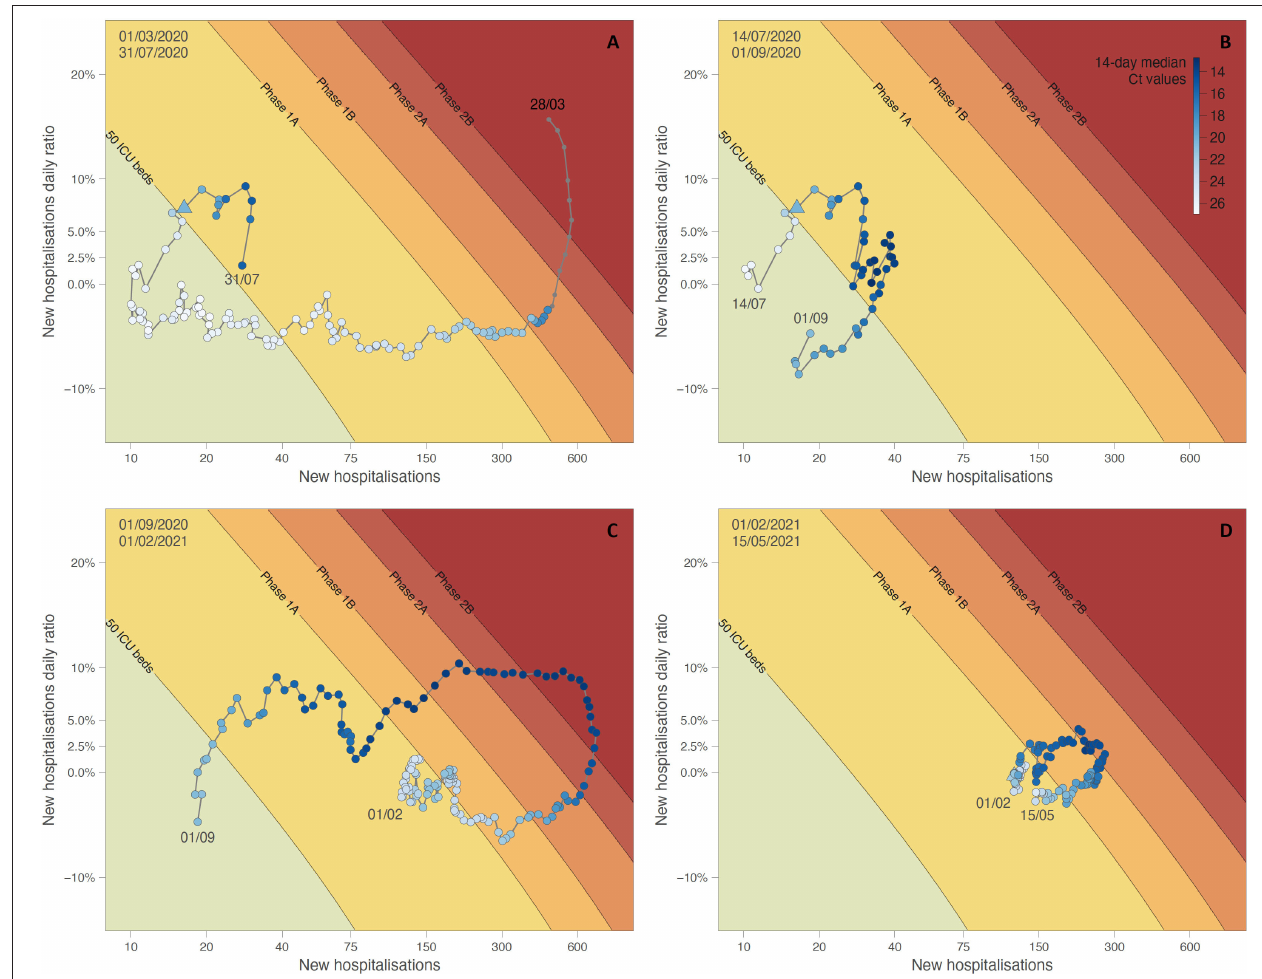
FIGURE 4 | Phase diagram generated for different time periods: situation from March 1 to July 14, 2020 (A) , situation from July 14 to September 1, 2020 (B) , and situation from September 1, 2020, to February 1, 2021 (C) , situation from February 1 until May 15, 2021 (D) . See the text for further detail on the principle of phase diagrams. Dots of the phase diagram are coloured according to 14-day median Ct values (thus computed using a backward sliding window of 14 days, from May 1, 2020). Triangle symbols indicate the dates when Ct values crossed down the threshold value of